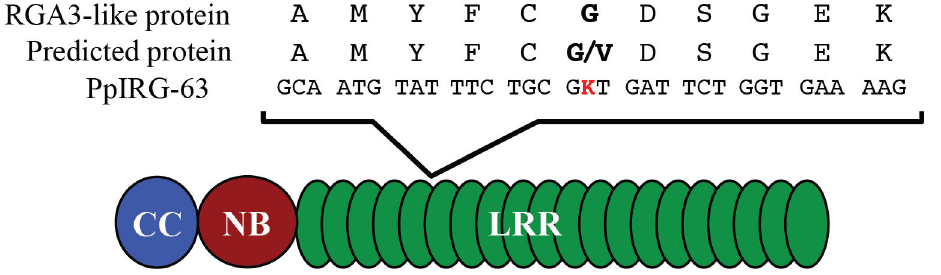
Figure 4. Single nucleotide polymorphisms (SNPs) detected in the PpIRG-63 marker located on the predicted LRR domain. Polymorphisms are shown in